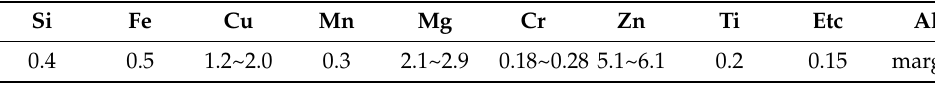
Table 1. Chemical composition of 7075-T7401 (%).